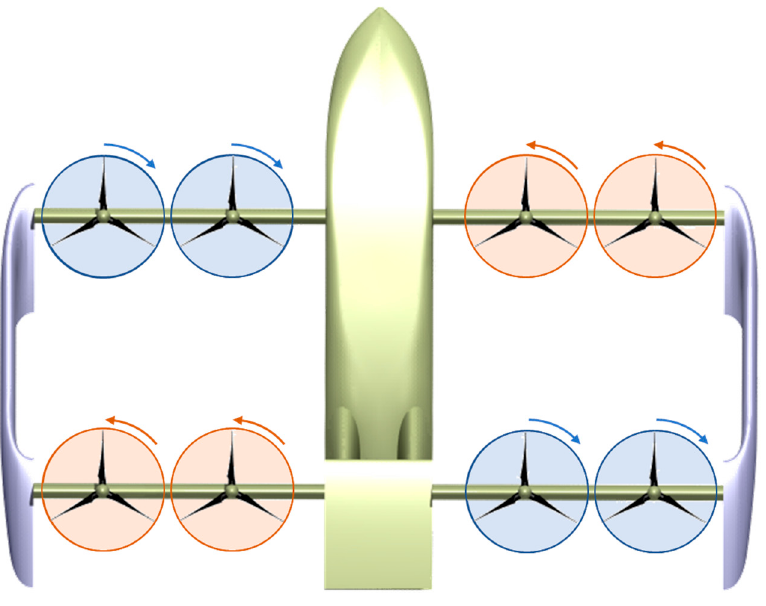
Figure 5. Qualitative scheme of installation of propulsors on the TiltOne (multi-rotor mode) .